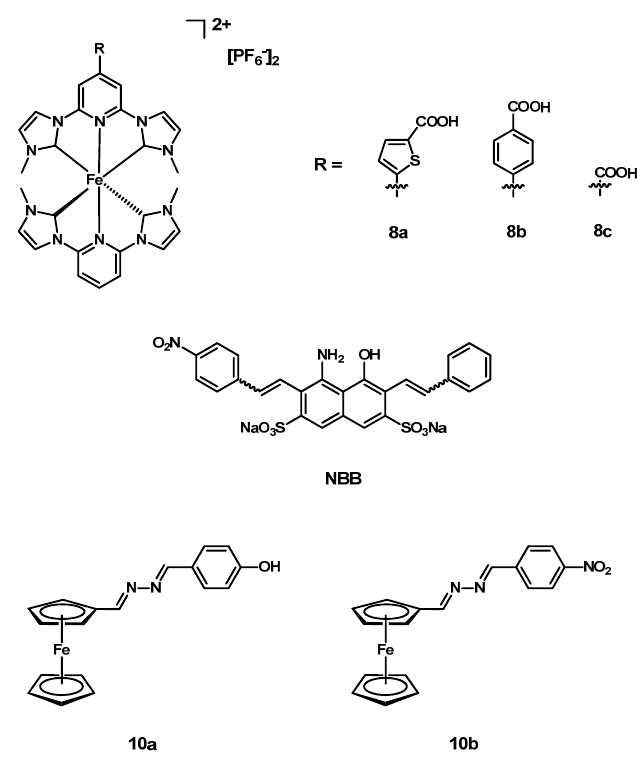
Figure 5. Structure of dyes 8a – c and 10a – b , and of Naphthol